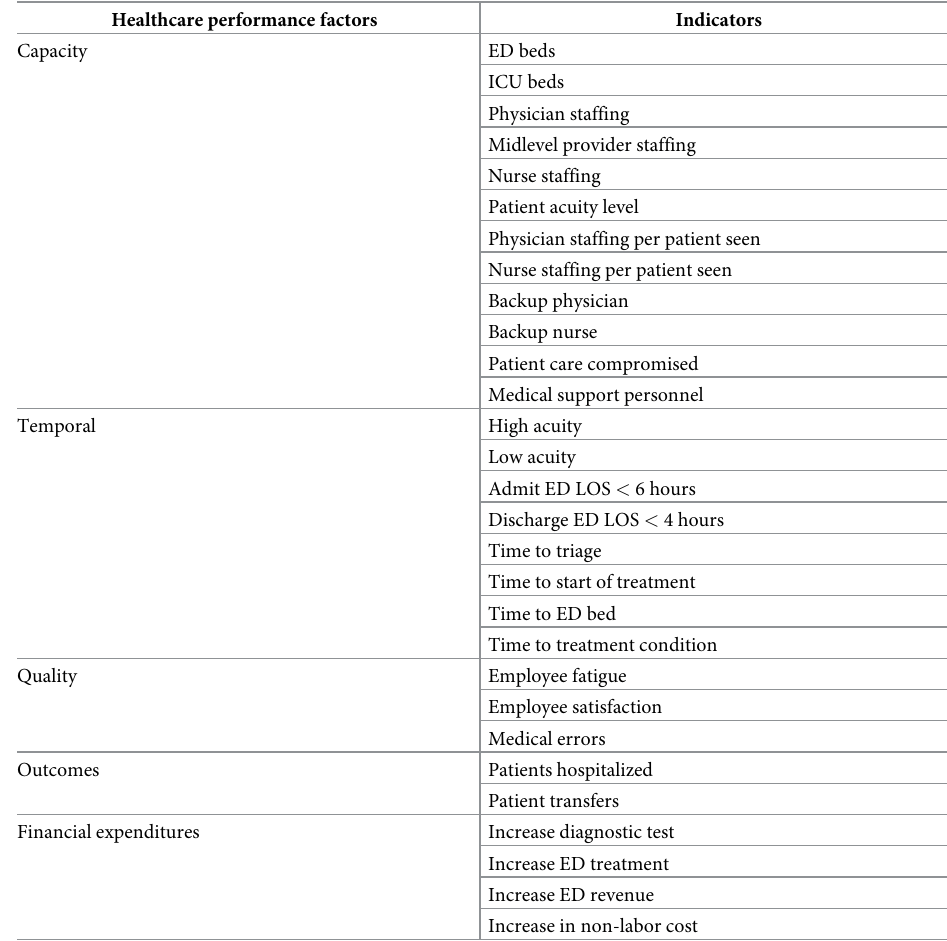
Table 1. List of potential